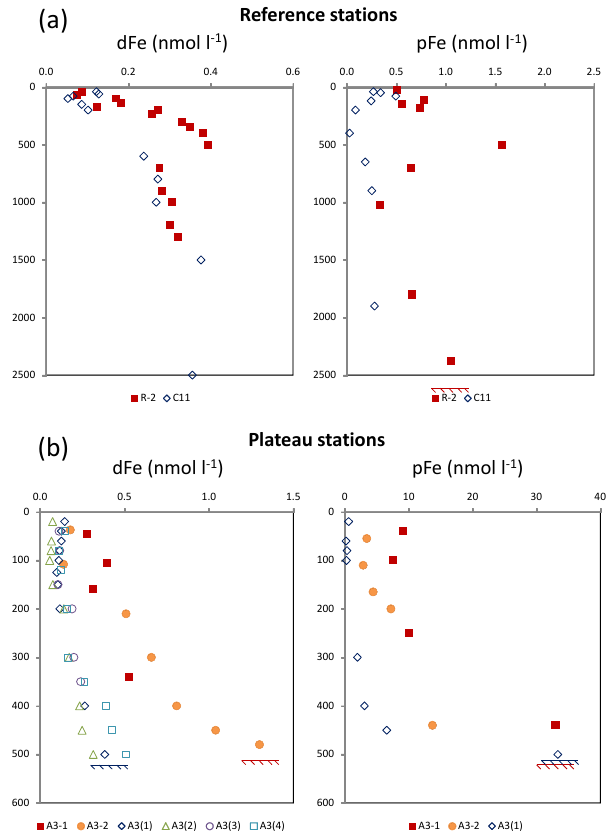
Figure 4. (a) Comparison of dFe and pFe at reference stations for KEOPS-1 (station C11, open blue diamonds) and KEOPS-2 (sta- tion R-2, closed red squares). The water depths were 3110m at C11 and 2530m at R-2. (b) Comparison of dFe and pFe at A3 plateau stations for KEOPS-1 (open symbols) and KEOPS-2 (closed sym- bols). Data are shown for all visits to A3 on both KEOPS cruises. Note difference in scale for dFe and pFe between (a) and (b)